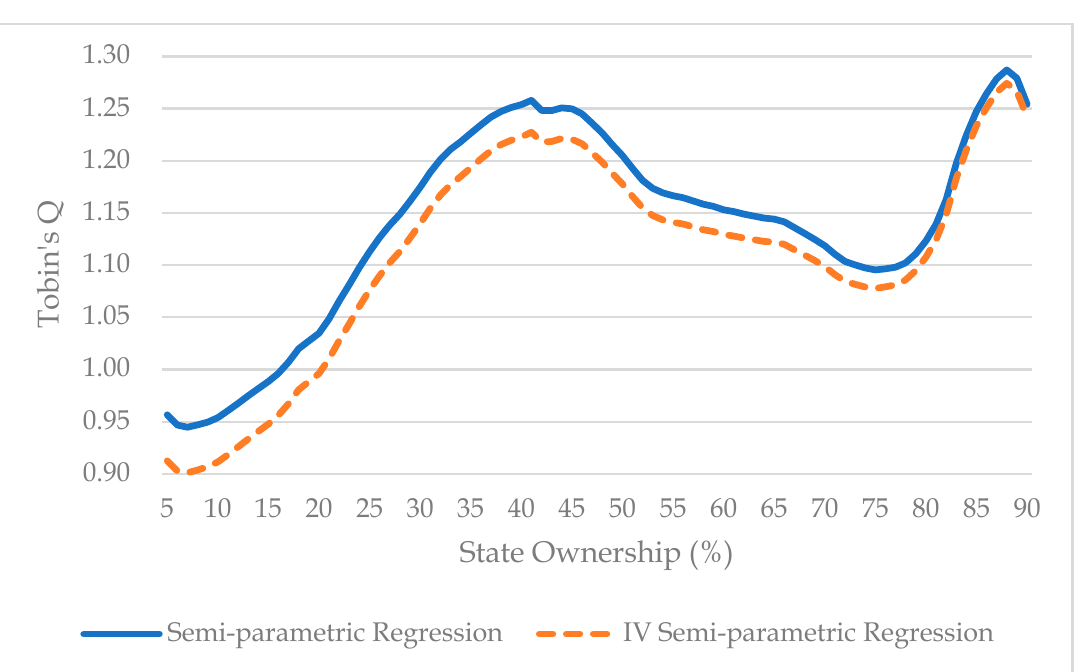
Figure A3. The marginal effect of state ownership (%) on partially privatized firm’s ROS (%) according to both semiparametric regression model and IV semiparametric regression model.